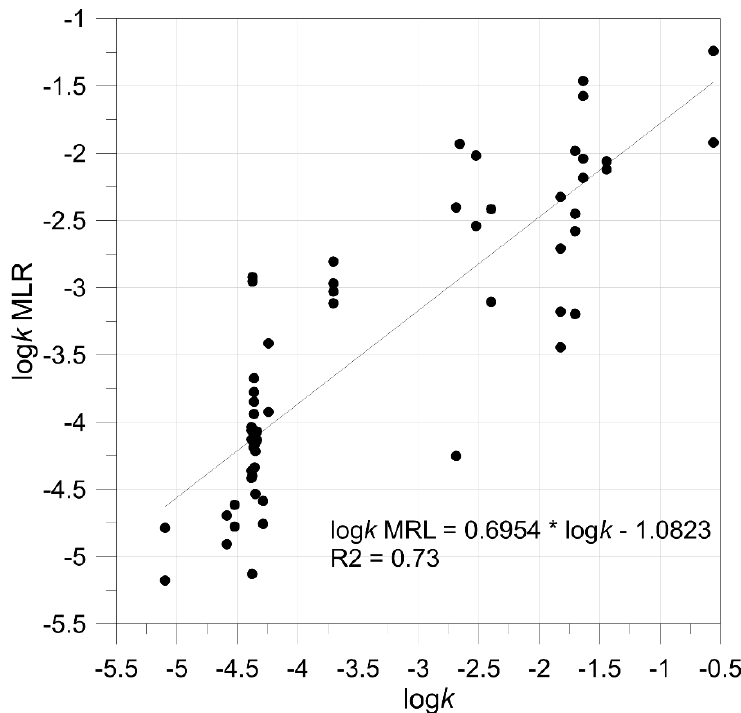
Figure 14. The logarithm of absolute permeability from the multiple linear regression in the function of the logarithm of absolute permeability from pulse or pressure decay laboratory method.